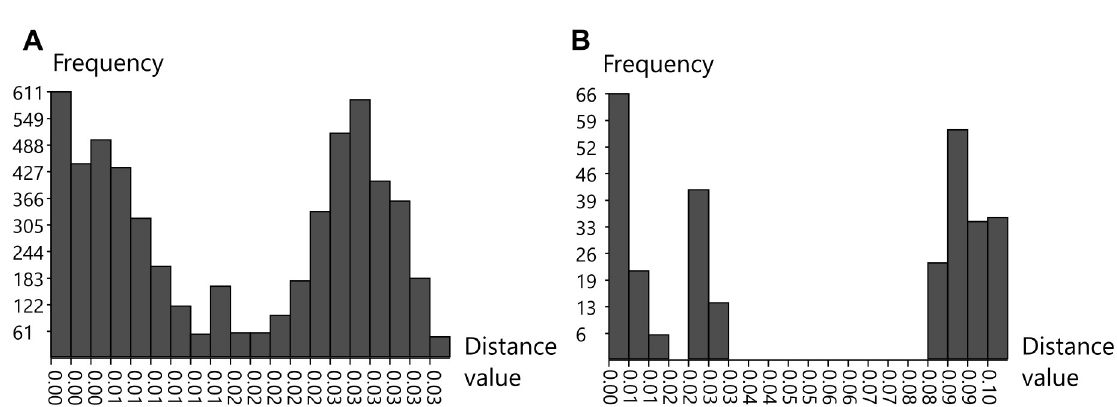
Fig 4. Distribution of pairwise differences obtained from ABGD analyses of L . schrolli complex (A) and Provanna (B) Cox1 sequences.